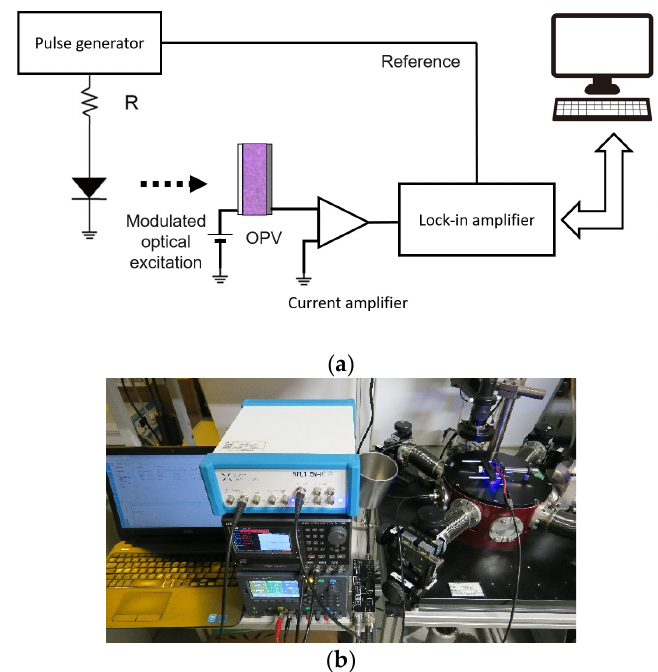
Figure 2. ( a ) Block diagram and ( b ) photograph of experimental setup of MPC spectroscopy.